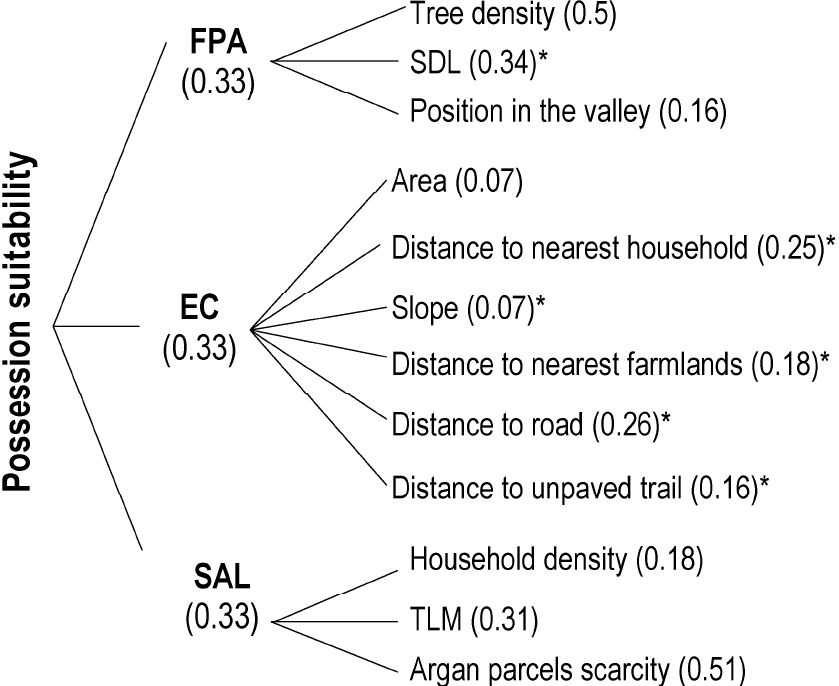
Figure 4. Components and weights (between brackets) used to estimate the possession suitability of argan parcels. All variables are standardized (between 0 and 1).